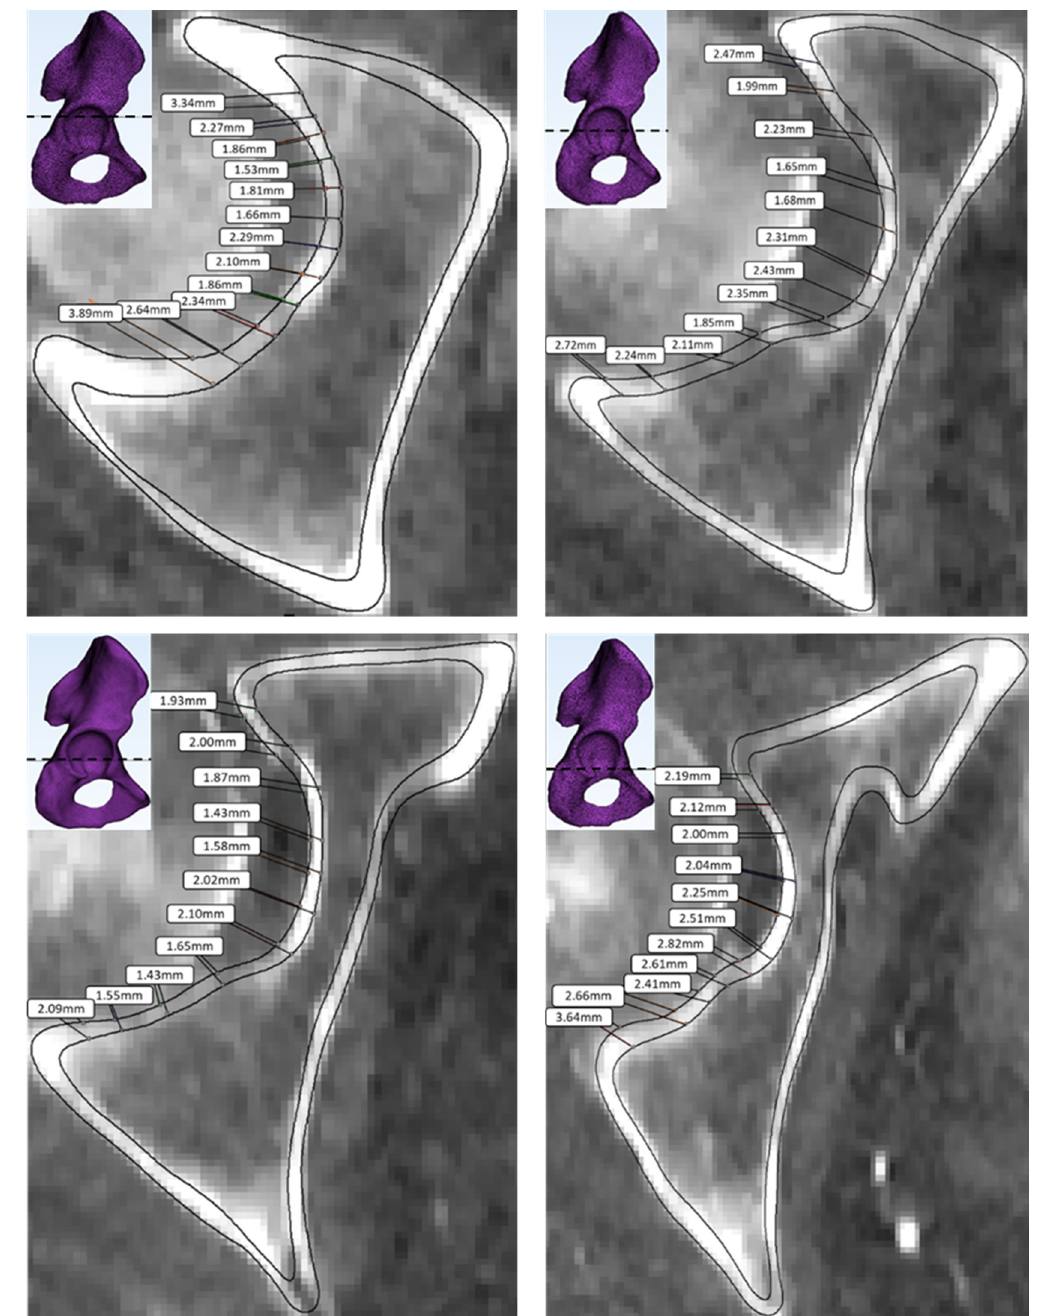
Figure A1. Cortical thickness at different sites of the acetabulum.